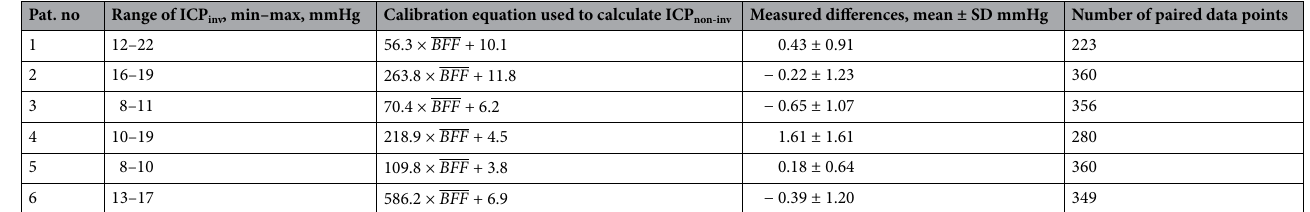
Table 2. The individual parameters obtained from each patient included in this pilot